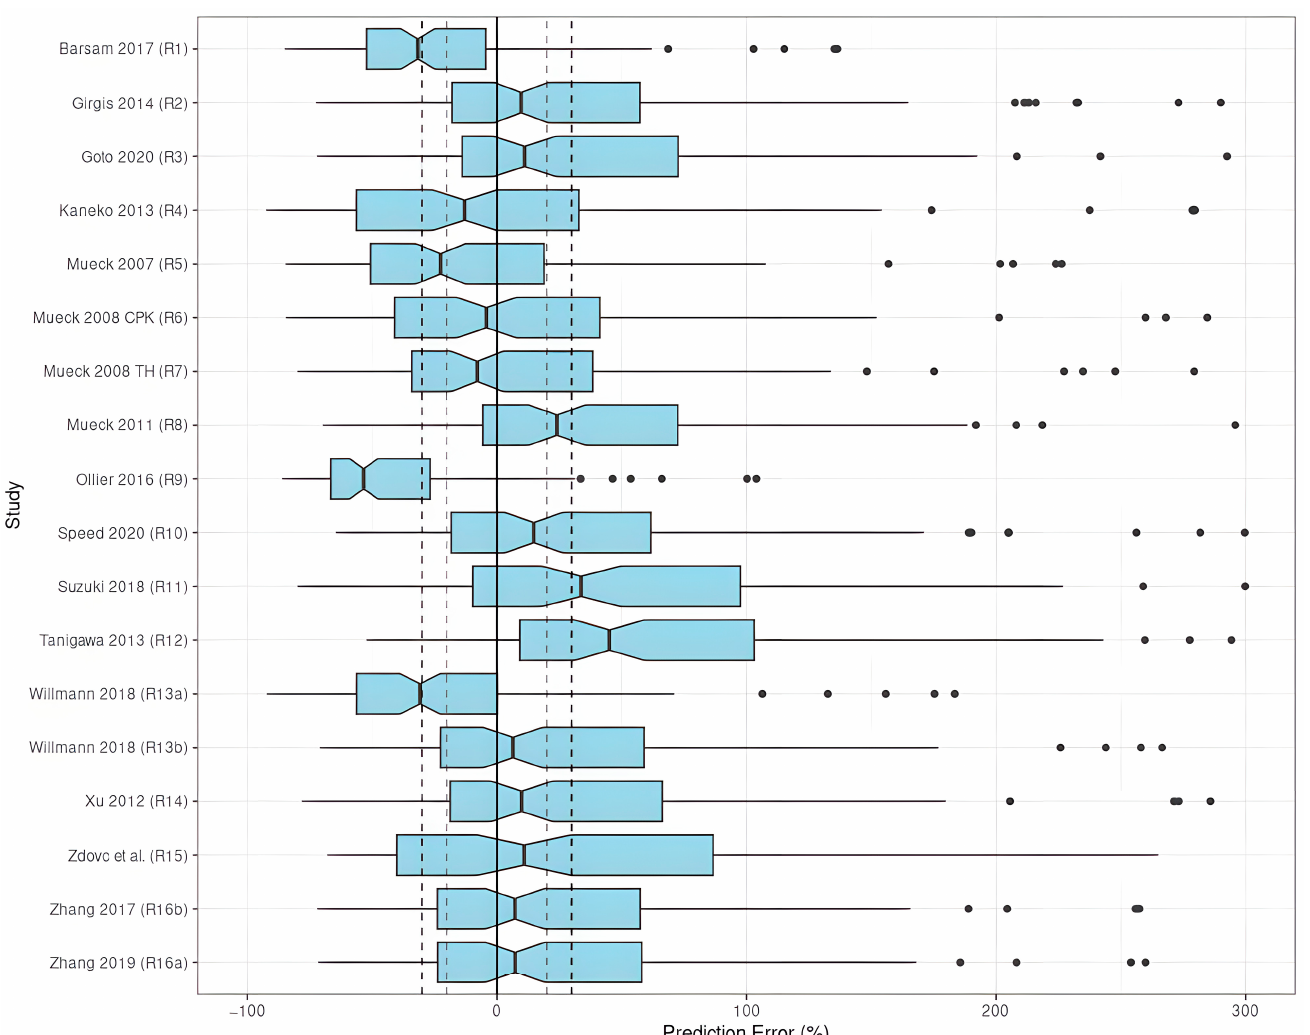
Figure 3. PE% of rivaroxaban population pharmacokinetic studies applied to the external validation dataset [8,24,27–40].